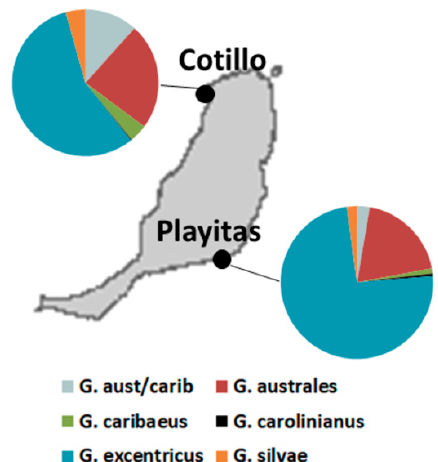
Figure 6. Relative mean abundances of Gambierdiscus species in Cotillo and Playitas stations on Fuerteventura Island.